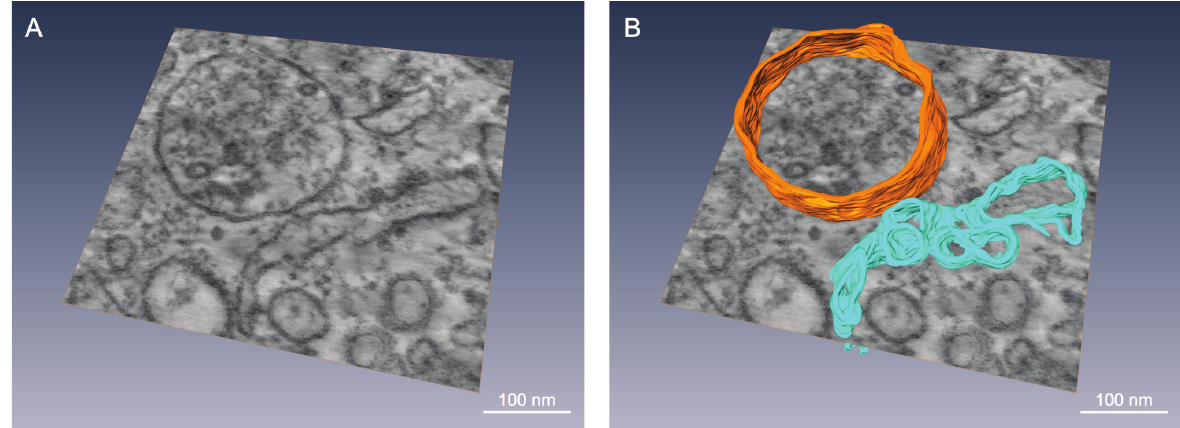
Figure 4. A , Snapshot from a TEM tomogram of a L-SR region of rat pulmonary artery smooth muscle, illustrating, among other things, a single SR extension apparently forming junctions with several lysosomes. Magnification: 62,000×. B , Same snapshot shown in A , but with a lysosome (orange) and a portion of SR (turquoise) partially traced out in 3D. These pseudocolour tracings underscore how the SR can appear as a large cistern in a given plane, but can actually branch out in different directions when viewed in 3D. Scale bars ≈ 100 nm.